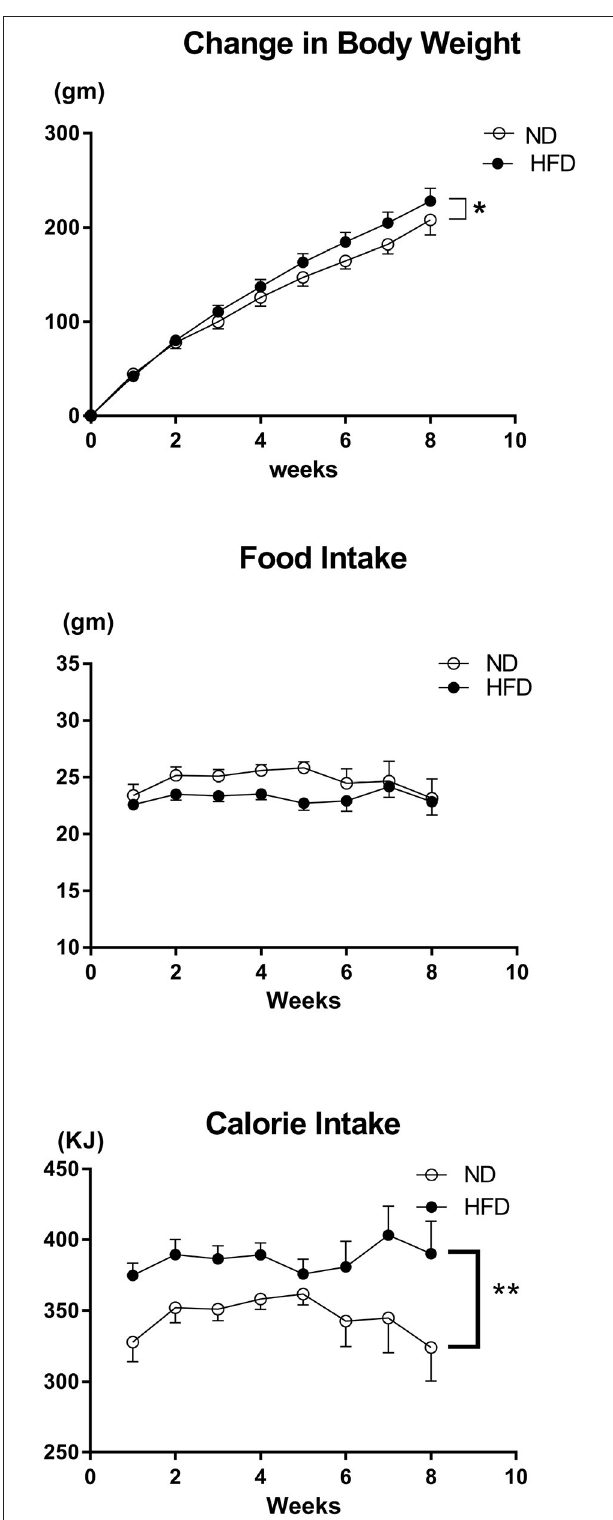
FIGURE 17 | Effect of high fat diet (HFD; n = 18) and normal diet (ND; n = 13) on the change in body weight, food intake per day and average calorie intake per day over time. * P < 0.01 compared with control. ** P < 0.0001 compared with control.